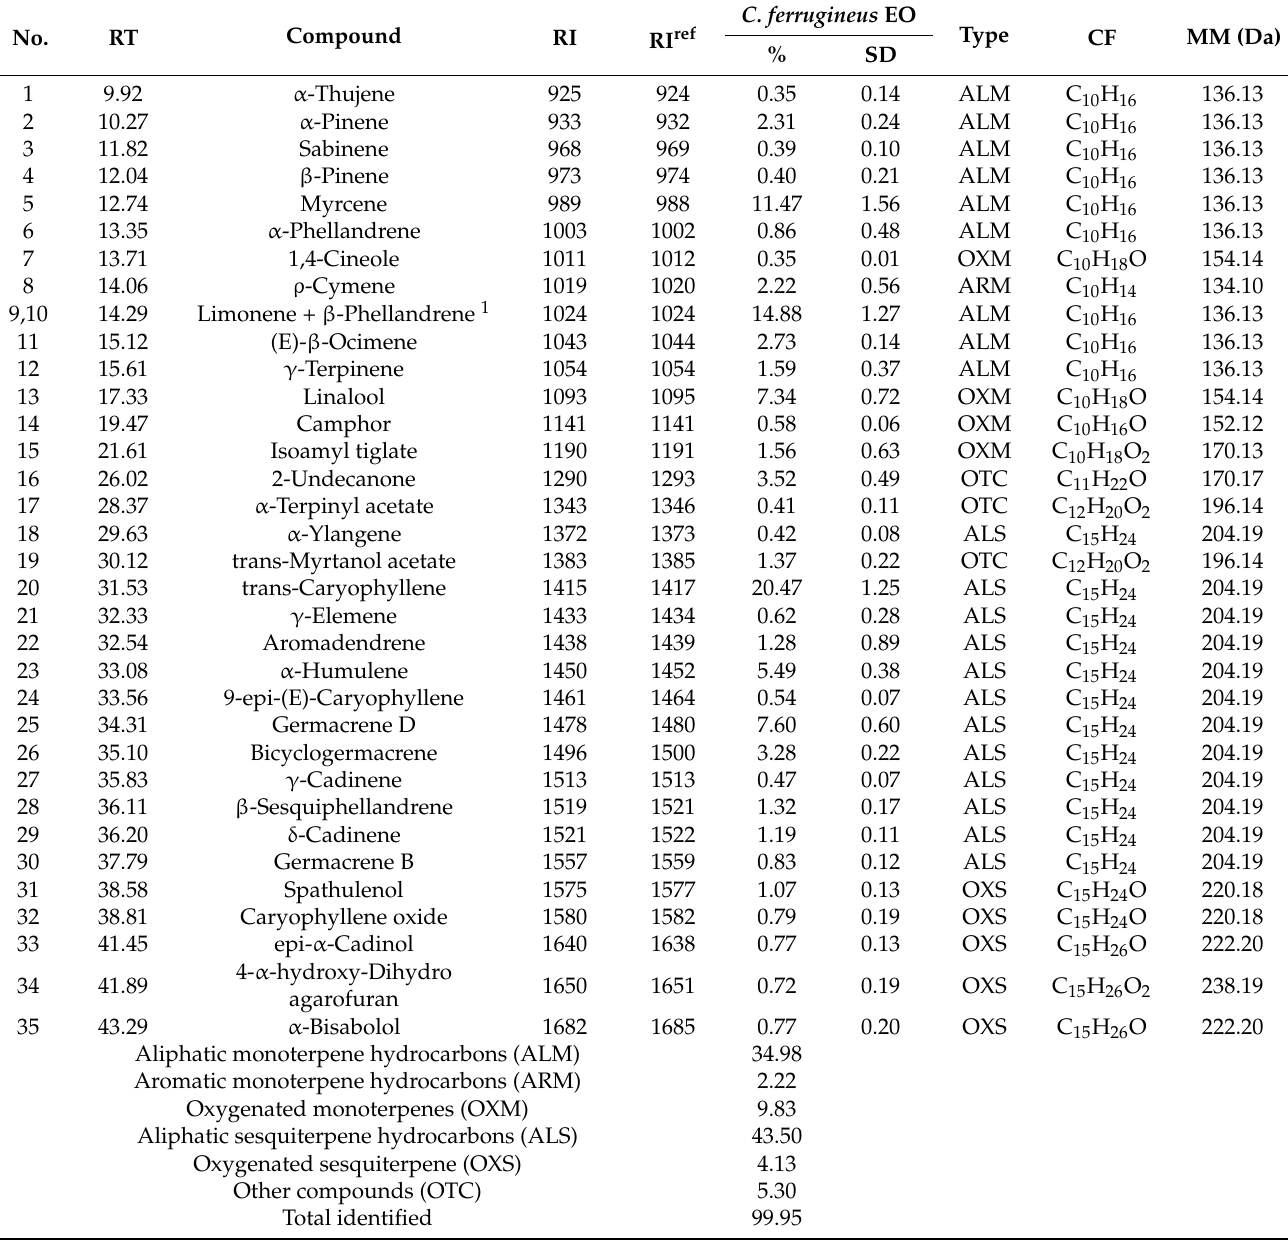
Table 1. Chemical compounds present in the essential oil from Croton ferrugineus